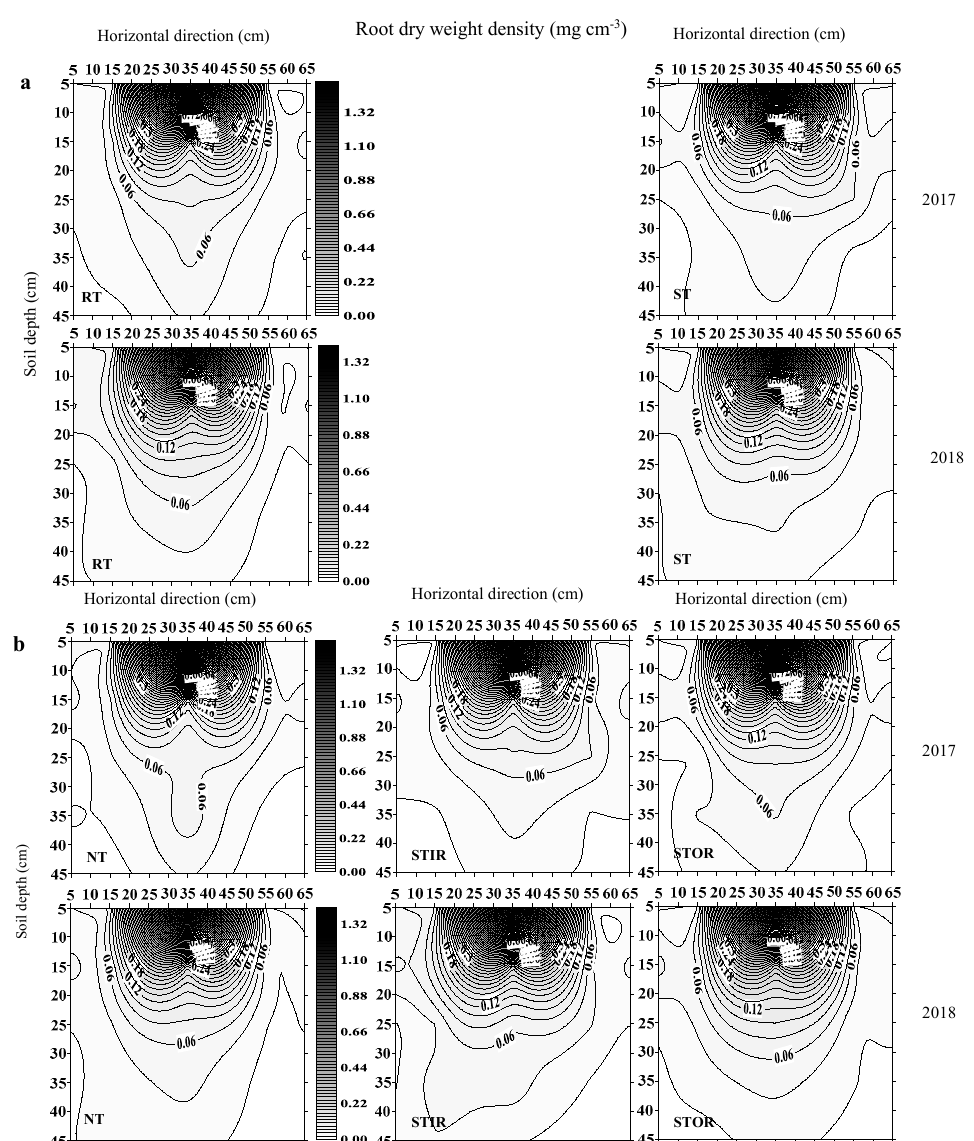
Figure 3. Effects of different tillage practices on root dry weight density in maize at the flowering stage. ( a ) wheat season tillage; ( b ) maize season tillage. RT: rotary tillage; ST: subsoiling tillage; STIR: inter–row subsoiling tillage; STOR: on–row subsoiling tillage.